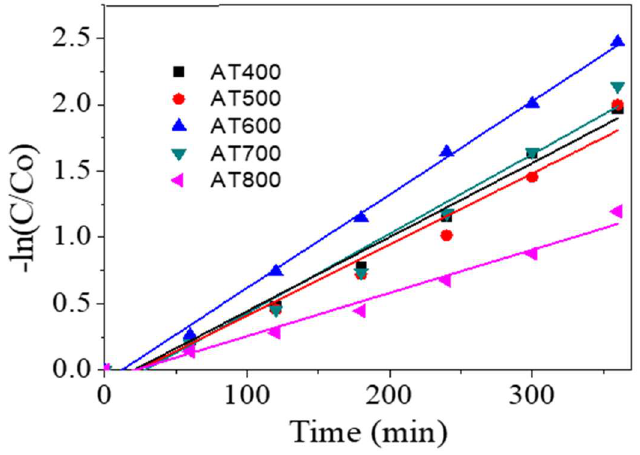
Figure 9. Pseudo-first-order kinetics for the photodegradation of phenol for the AT series.